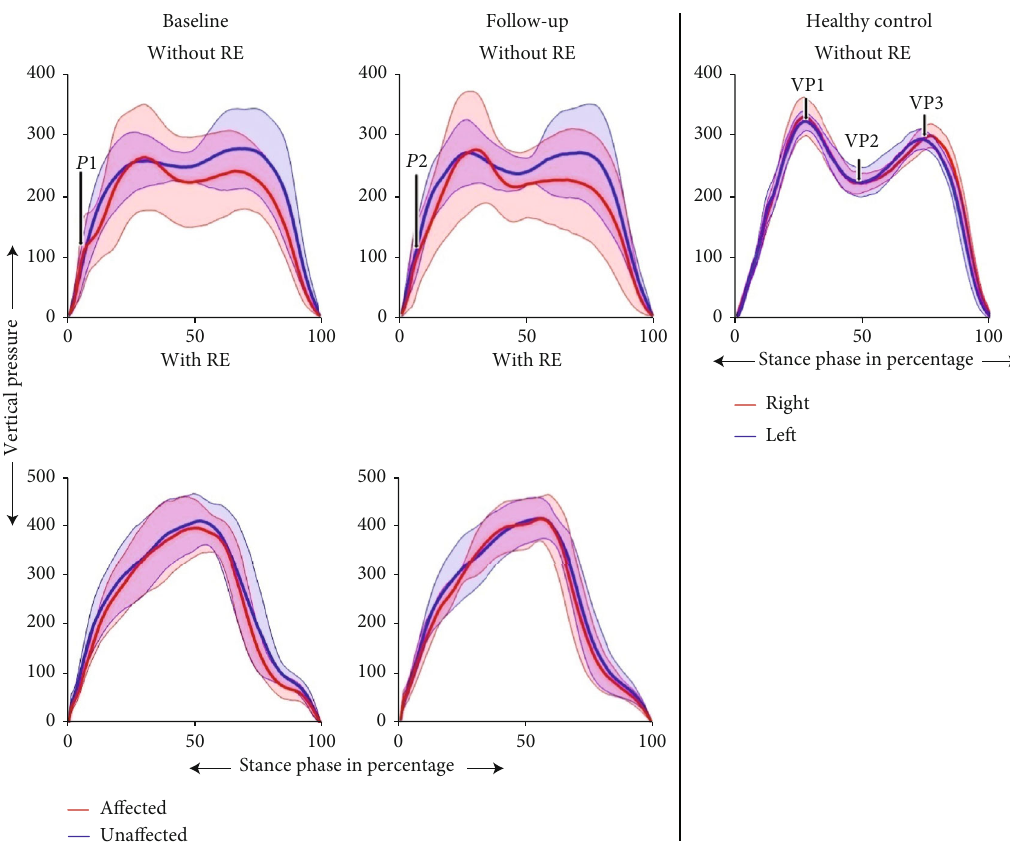
Figure 2: Mean ± standard deviation of the TVP of the a ff ected and una ff ected leg of individuals with ABI during walking with and without an RE at baseline and follow-up and one reference HC. Data is normalized to 100% of the stance